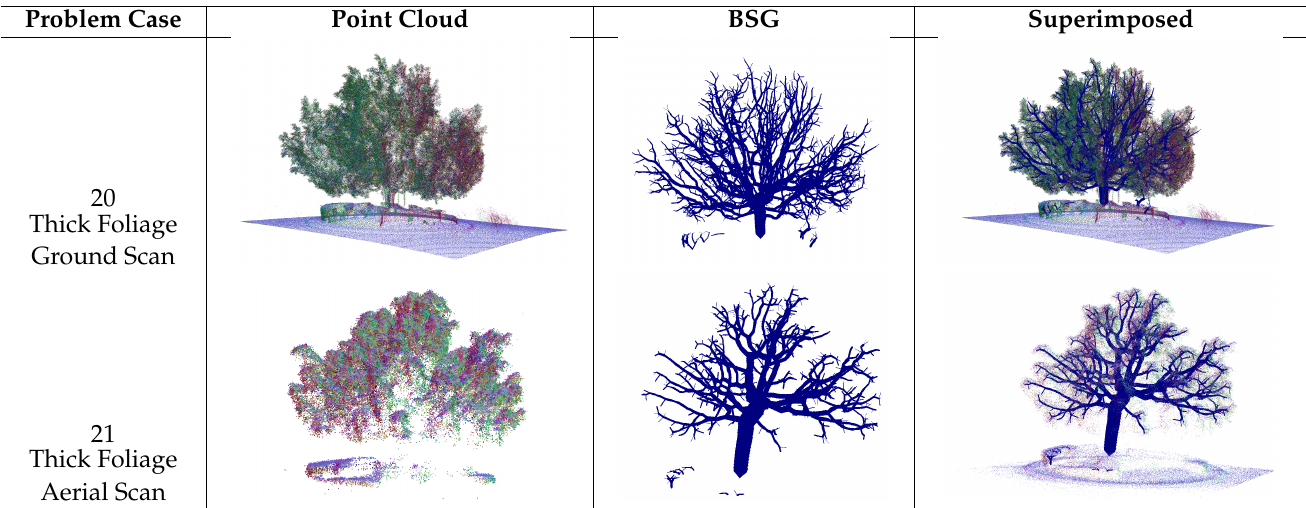
Table 5. Aerial comparison: of a tree reconstructed from high-density ground data and sparse aerial data of a Moreton Bay fig